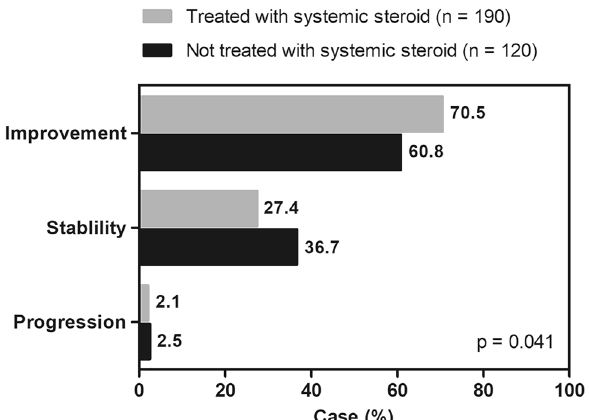
Figure 3. Clinical course of pulmonary sarcoidosis according to treatment status. The grey bars represent patients with pulmonary sarcoidosis treated with systemic steroids, while the black bars represent those without treatment.